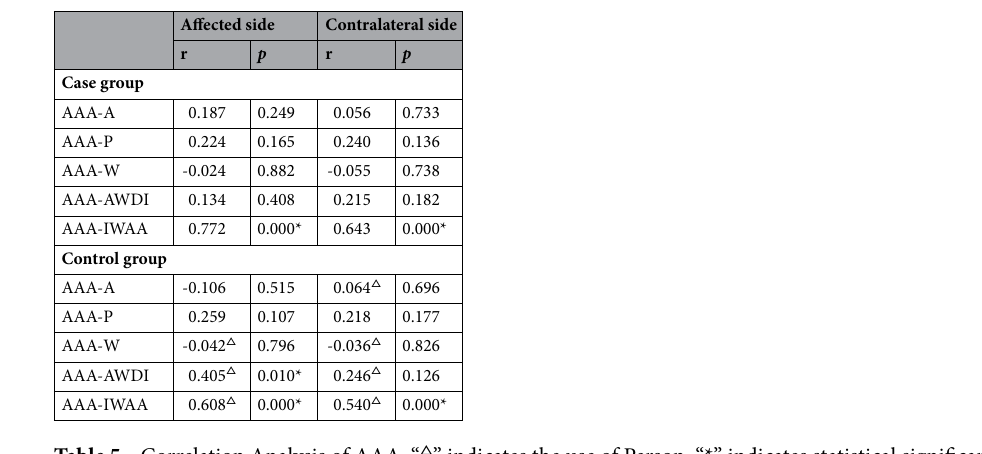
Table 5. Correlation Analysis of AAA. “ △ ” indicates the use of Person, “*” indicates statistical significance.